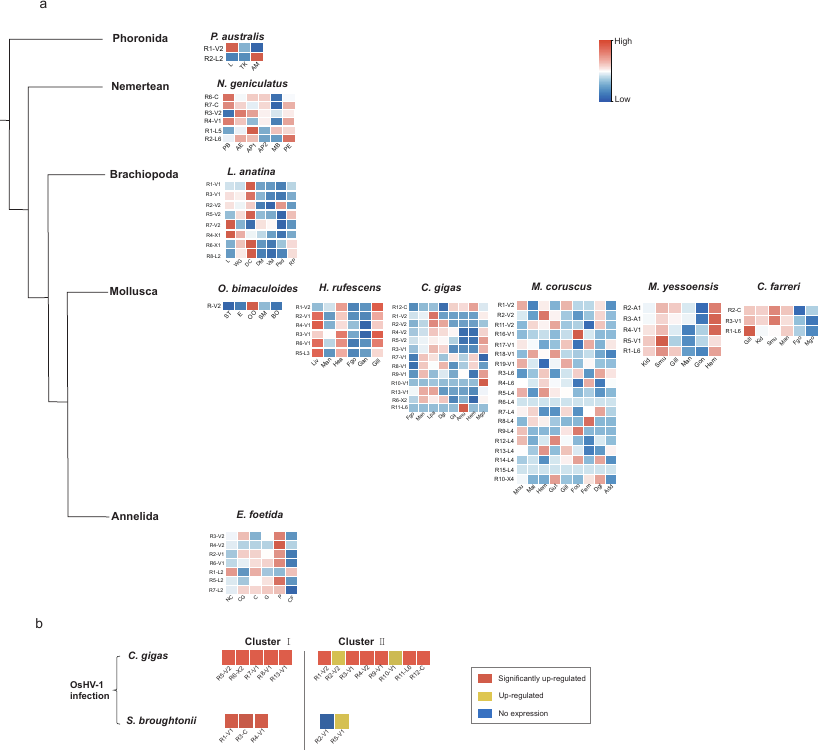
Figure 7. Expression patterns of RLR genes among different tissues and under virus infection. ( a ) Transcriptome expression heatmaps of RLRs of different tissues in ten Lophotrochozoa species. Ampulla (AM), trunk (TK), proboscis (PB), anterior end (AE), anterior part1 (AP1), anterior part2 (AP2), mid-body (MB), posterior end (PE), lophophore (L), whole gut tissue (WG), digestive cecum (DC), dorsal mantle (DM), ventral mantle (VM), pedicle (Ped), regenerated pedicle (RP), statocyst tissue (ST), eye (E), olfactory organ (OO), skin from mantle (SM), brain tissue from optic lobe (BO), liver (Liv), mantle (Man), heart (Hea), female gonad (Fgo), adult female ganglion (Gan), gill (Gill), labial palp (Lpa), digestive gland (Dgl), adductor muscle (Amu), hemocyte (Hem), male gonad (Mgo), mouth (Mou), male gonad (Mal), foot (Foo), female gonad (Fem), adductor muscle (Add), kidney (Kid), striated muscle (Smu), gonad (Gon), nerve cord (NC), chlorogog gut (CG), crop (C), gizzard (G), pharynx (P), coelomic fluid (CF). Heatmap displays the expression level of RLR genes. ( b ) Transcriptional change of the RLRs under Ostreid herpesvirus-1 (OsHV-1) infection. The orange rectangle represents significantly upregulated RLR genes (Log2(FC) > 1.5); the yellow rectangle represents the upregulated RLR genes but not significantly; the blue rectangle represents the RLR genes that are not